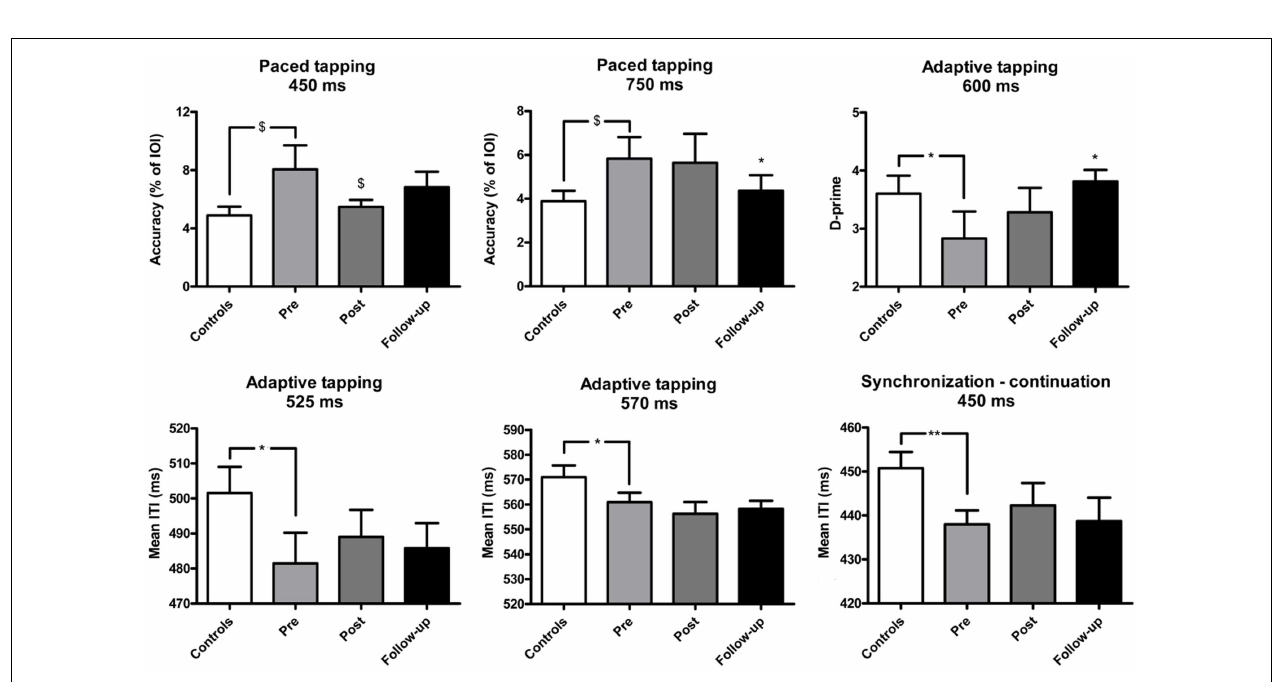
FIGURE 2 | Mean performance of IPD patients and controls in the motor tasks of the BAASTA .Tasks where patients differed from controls before the cueing training are selectively reported. Error bars indicate the standard error of the mean (SEM). * p < 0.05; ** p < 0.01; $ marginally significant difference.